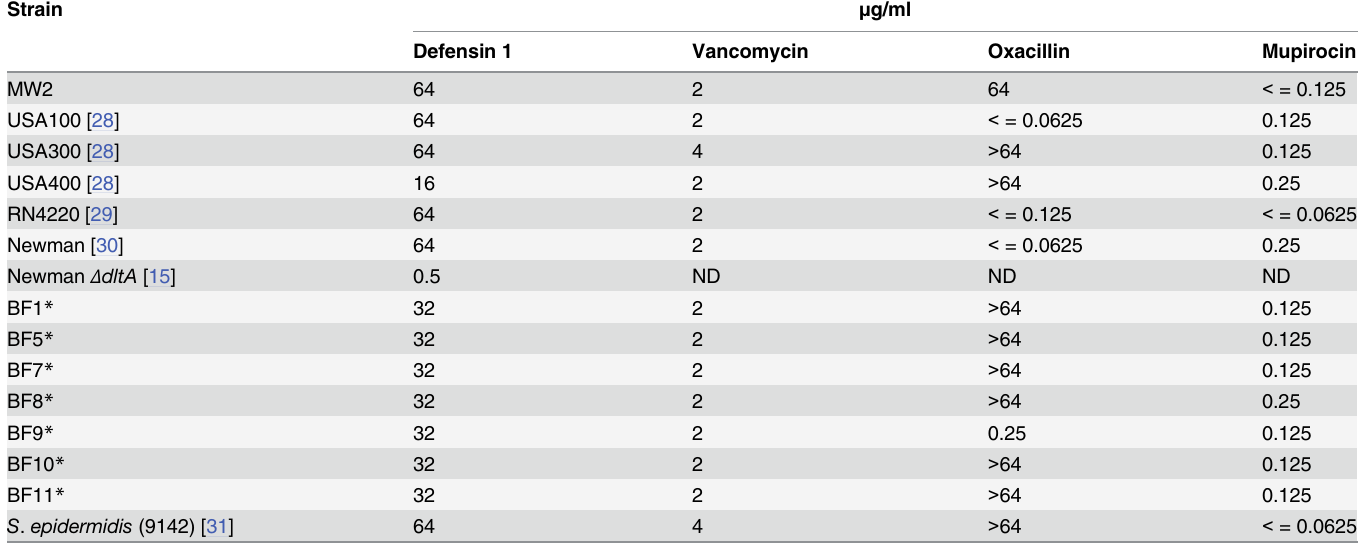
Table 1. Comparative antibacterial activities of defensin 1, vancomycin, oxacillin, and mupirocin against staphylococcal strains.